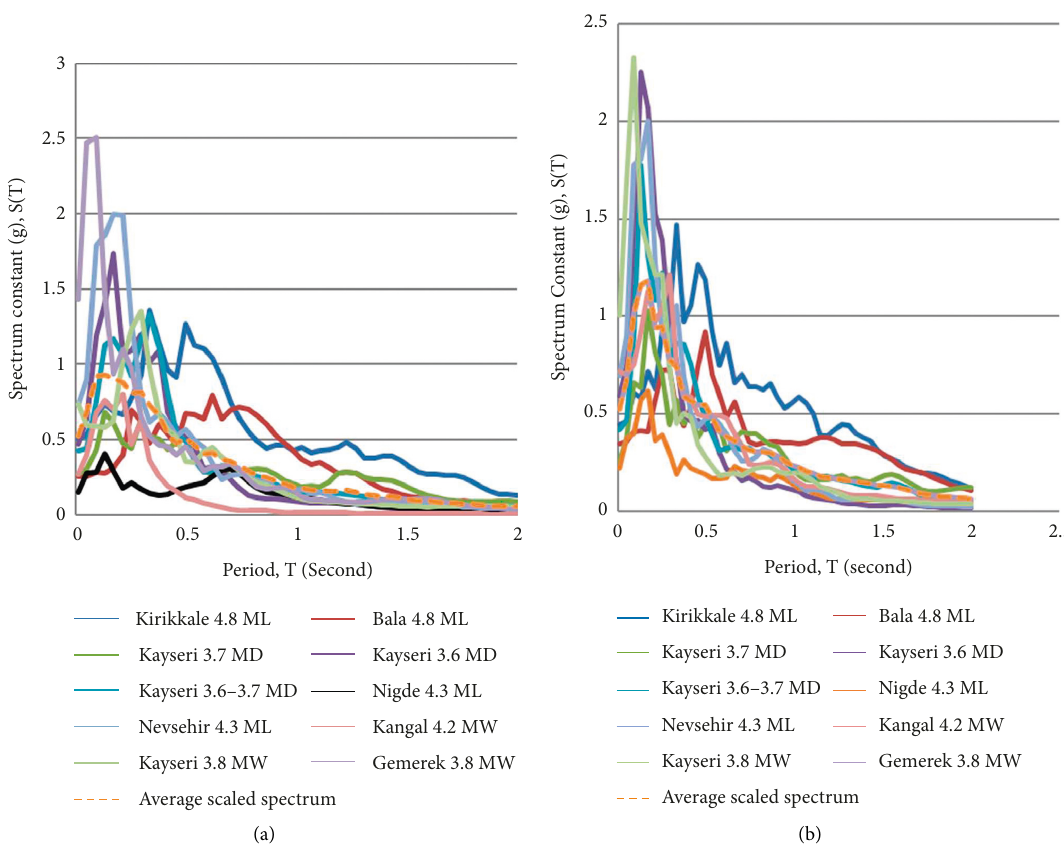
Figure 6: Response spectra of earthquake records scaled according to elastic design acceleration spectrum (with local site class Z2); (a) North-South (N-S) and (b) East-West (E-W)